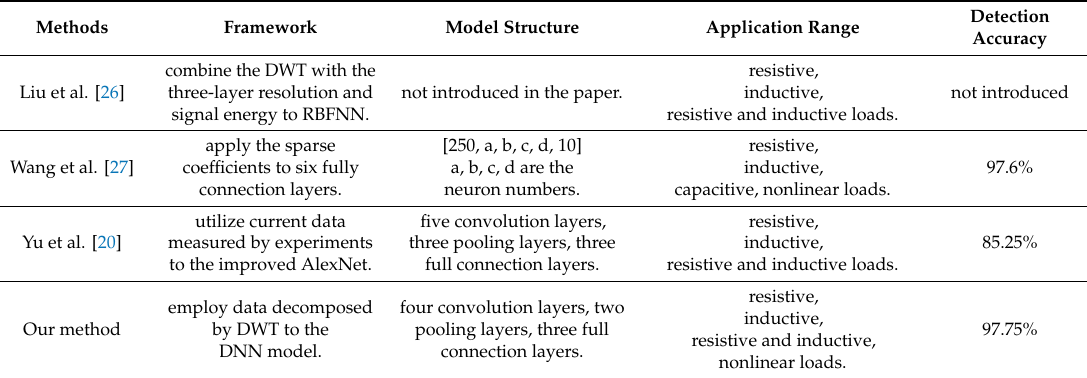
Table 4. Comparison with period